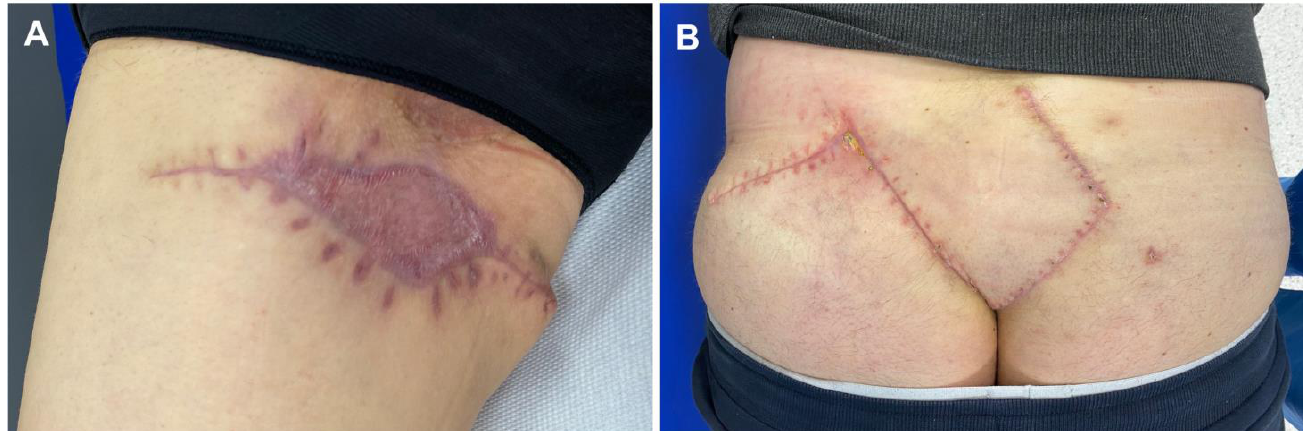
Figure 1. Completely healed patients after surgical treatment of hidradenitis suppurativa: ( A ) pa- tient with a 6-month follow-up post-co-graft of ADM and STSG (right groin); ( B ) patient with a 6- month follow-up post-skin flap reconstruction with PRP injections. Legend: ADM, acellular dermal matrix; STSG, split-thickness skin graft; PRP, platelet-rich